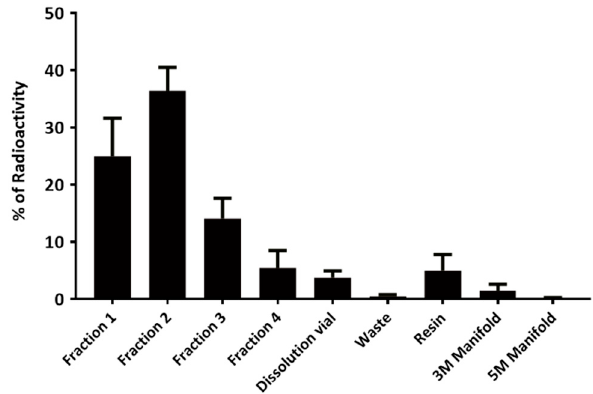
Figure 4. Recovered and residual 89 Zr activities in the purification module components ( n = 7).